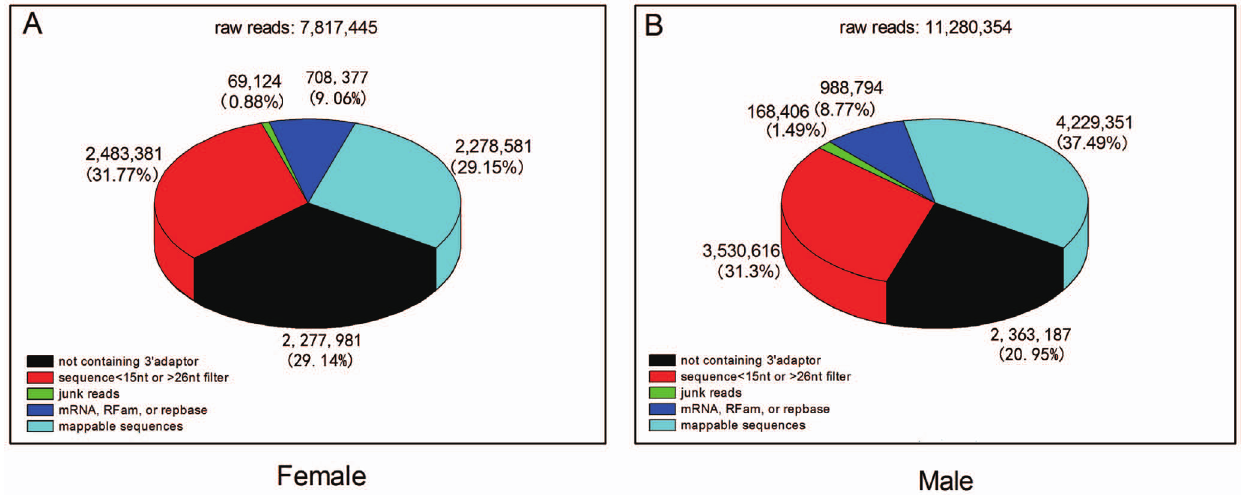
Figure 1. Statistics of small RNA sequences from the female (A) and male (B) E.sinensis libraries. The raw reads were classified into five separate categories, Mappable sequences states the raw reads were passed through a series of the digital filters by Illumina’s Genome Analyzer